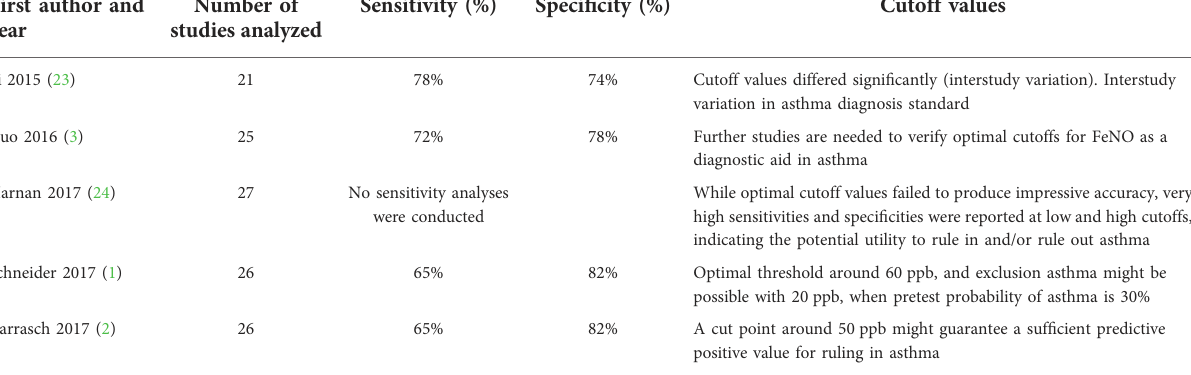
TABLE 1 Diagnostic accuracy of FeNO in 5 meta-analysis with QUADAS-2 (22) quality